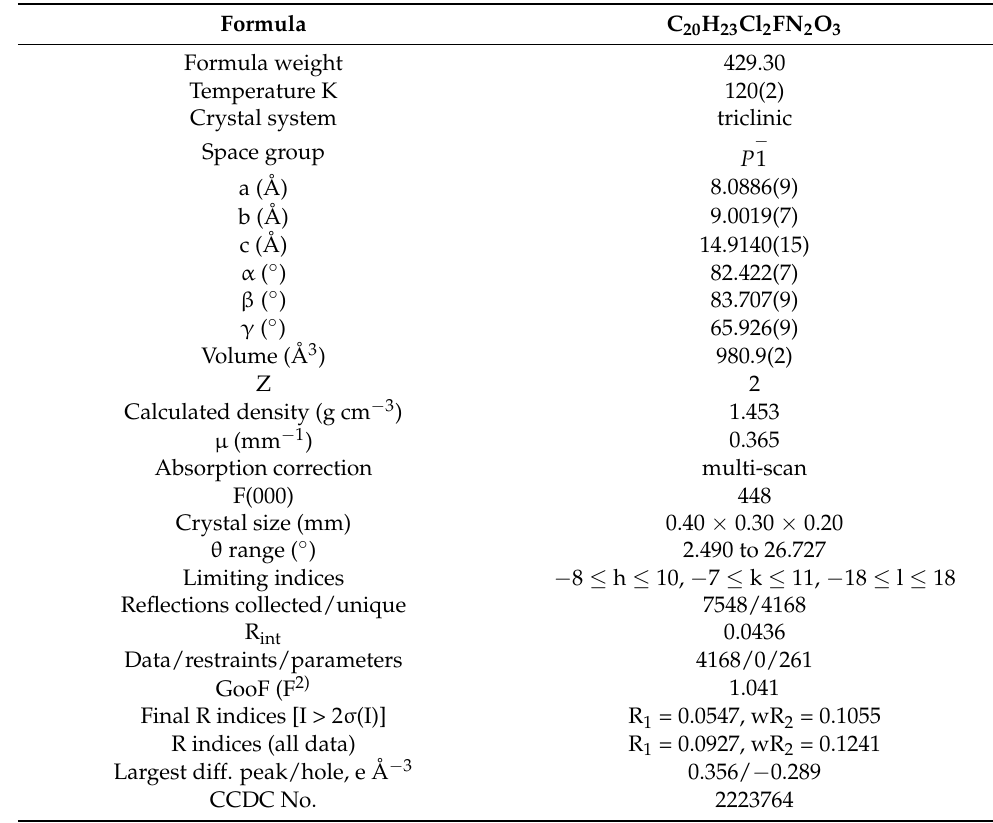
Table 1. Crystal data and structure refinement for D2AAK5.